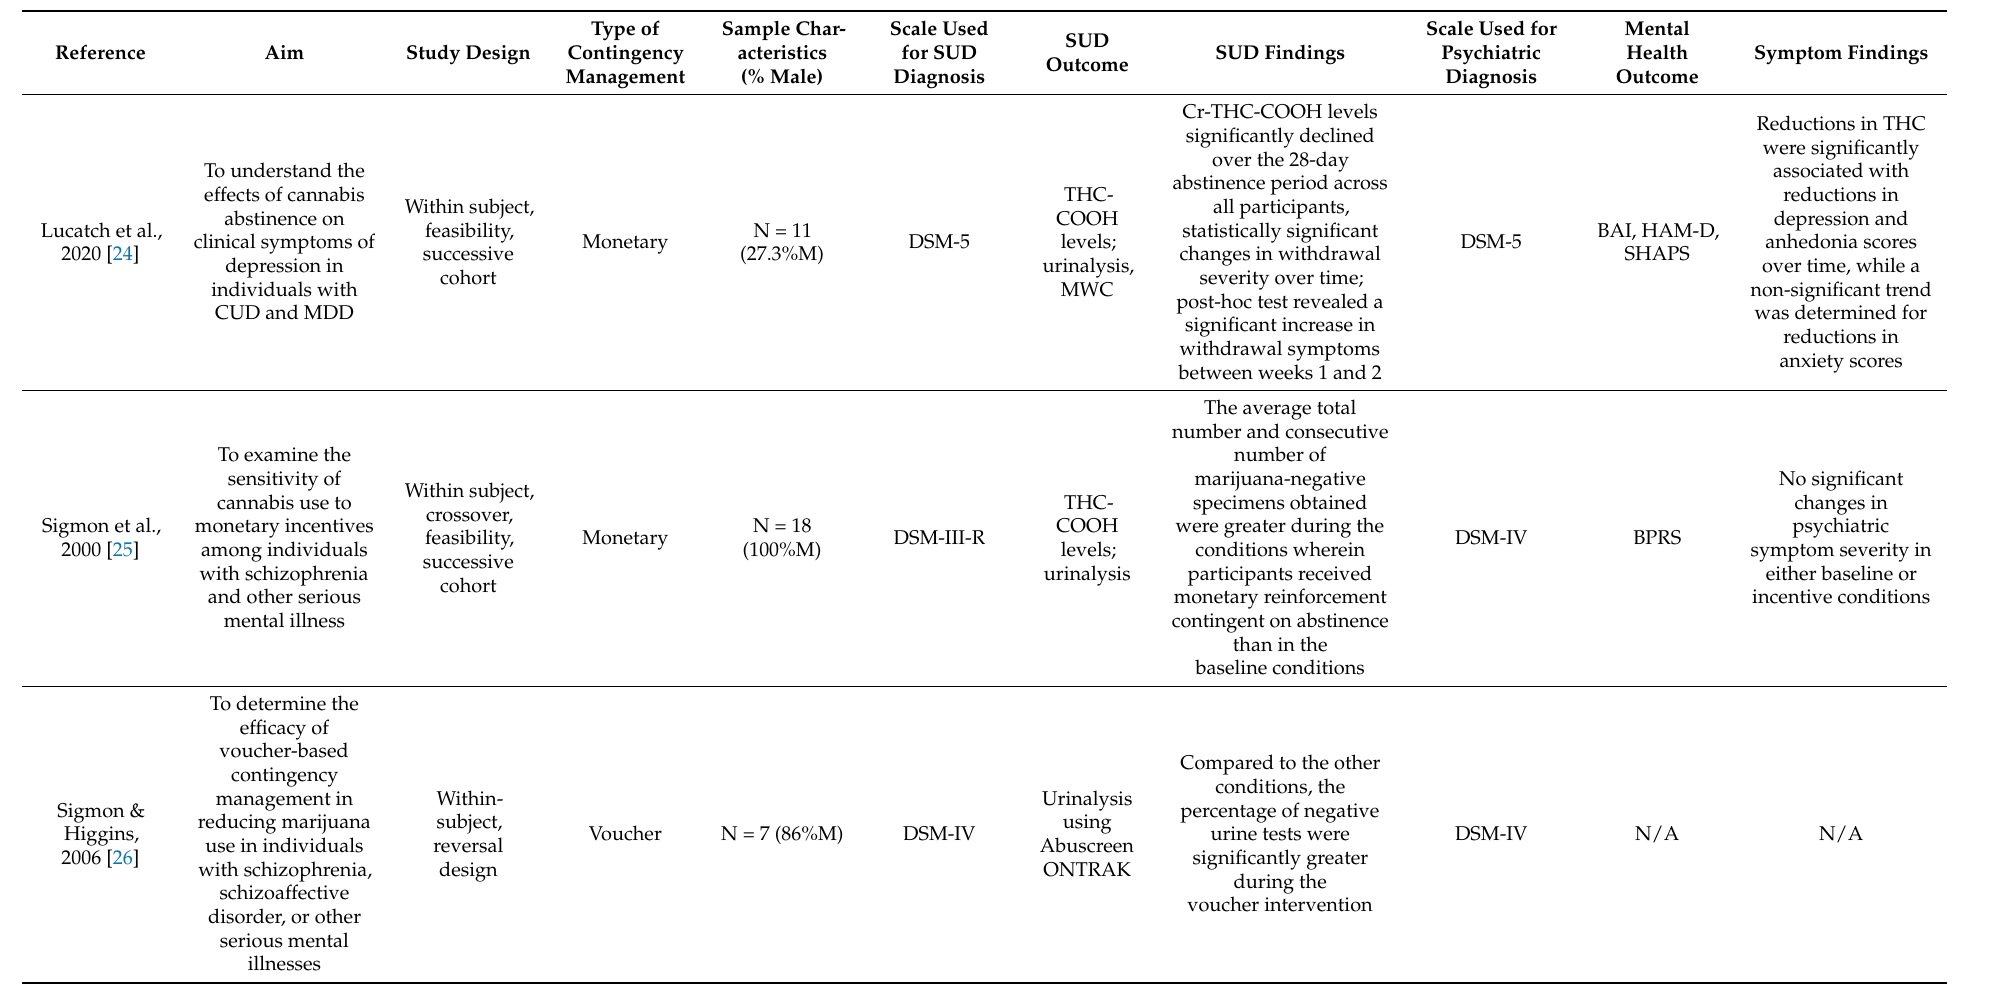
Table 1. Review of Evidence Concerning the Efficacy of Contingency Management on Substance Use and Psychiatric